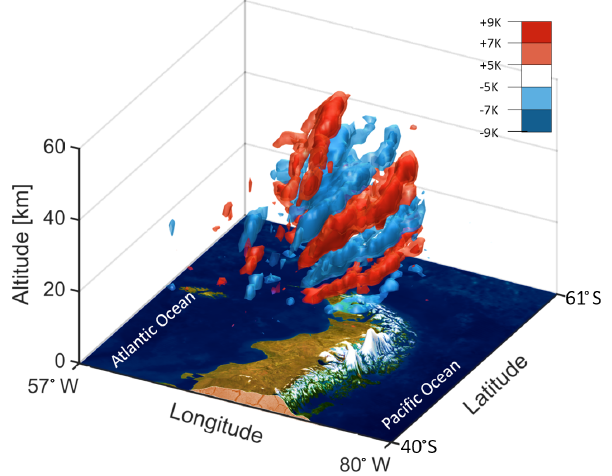
Figure 3. 3-D plot of the AIRS-derived T (cid:48) measurements shown in Fig. 2, plotted as semi-transparent nested surfaces of constant T (cid:48) . Viewing perspective has been rotated relative to Fig. 2 to better highlight 3-D T (cid:48) phase fronts present in the signal, and the expo- nential increase in wave amplitude with altitude has been removed in order to highlight the vertical